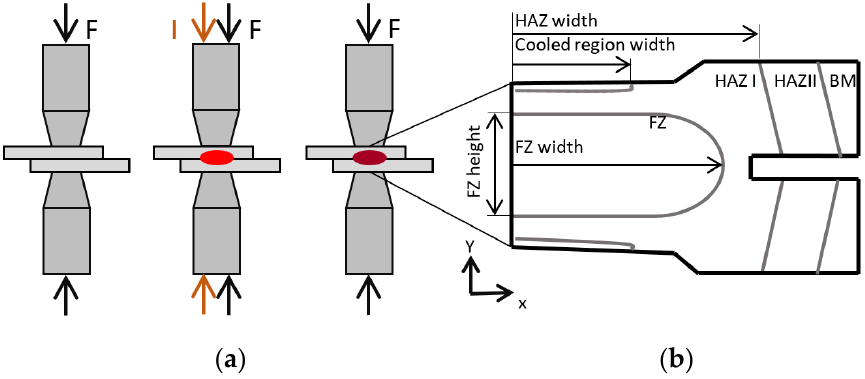
Figure 1. ( a ) RSW process steps: 1st clamping of electrodes and applying the welding force, 2nd initiating the welding current and 3rd hold time, ( b ) the different zones of the weld and LME locations [15].